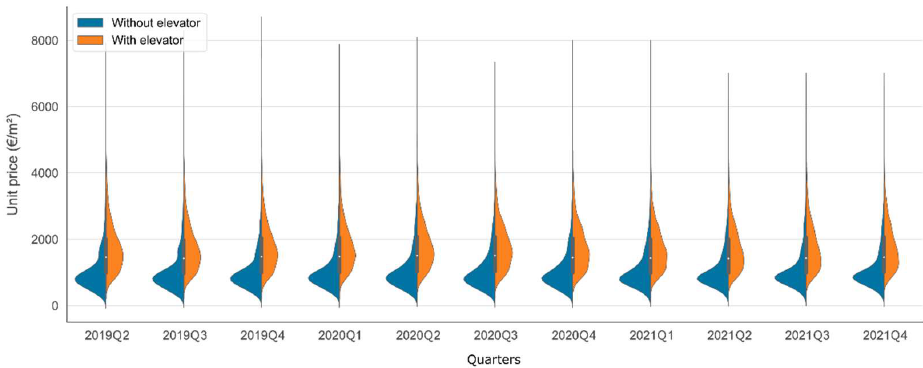
Figure 8. Violin chart with the distribution of the unit price (€/m²) for properties with and without an elevator, according to each quarter analyzed.